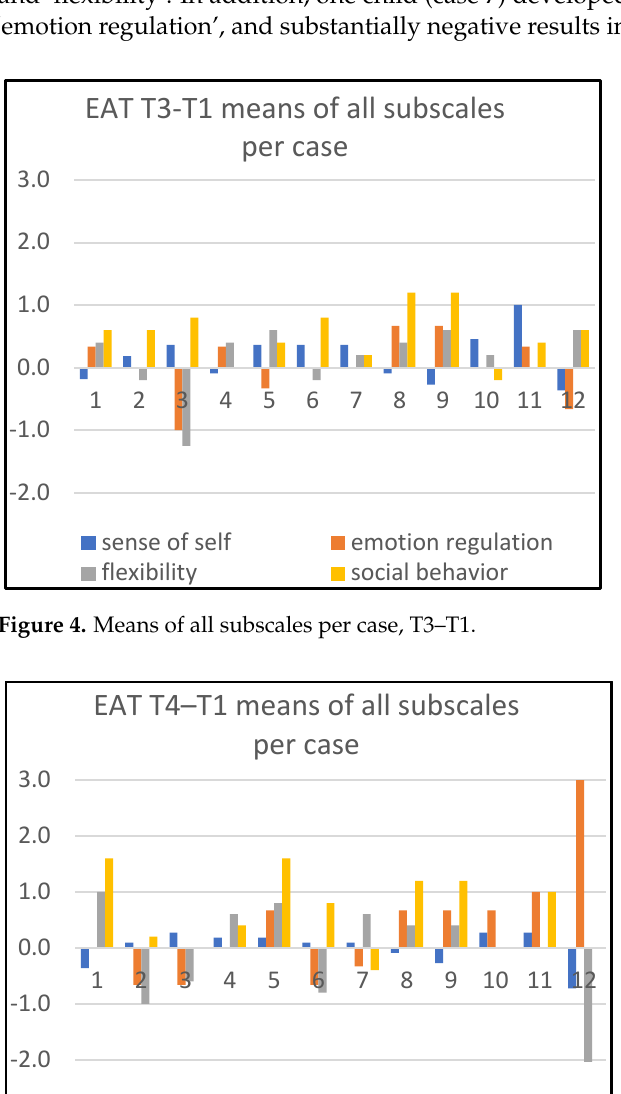
Figure 5. Means of all subscales per case, T4–T1.